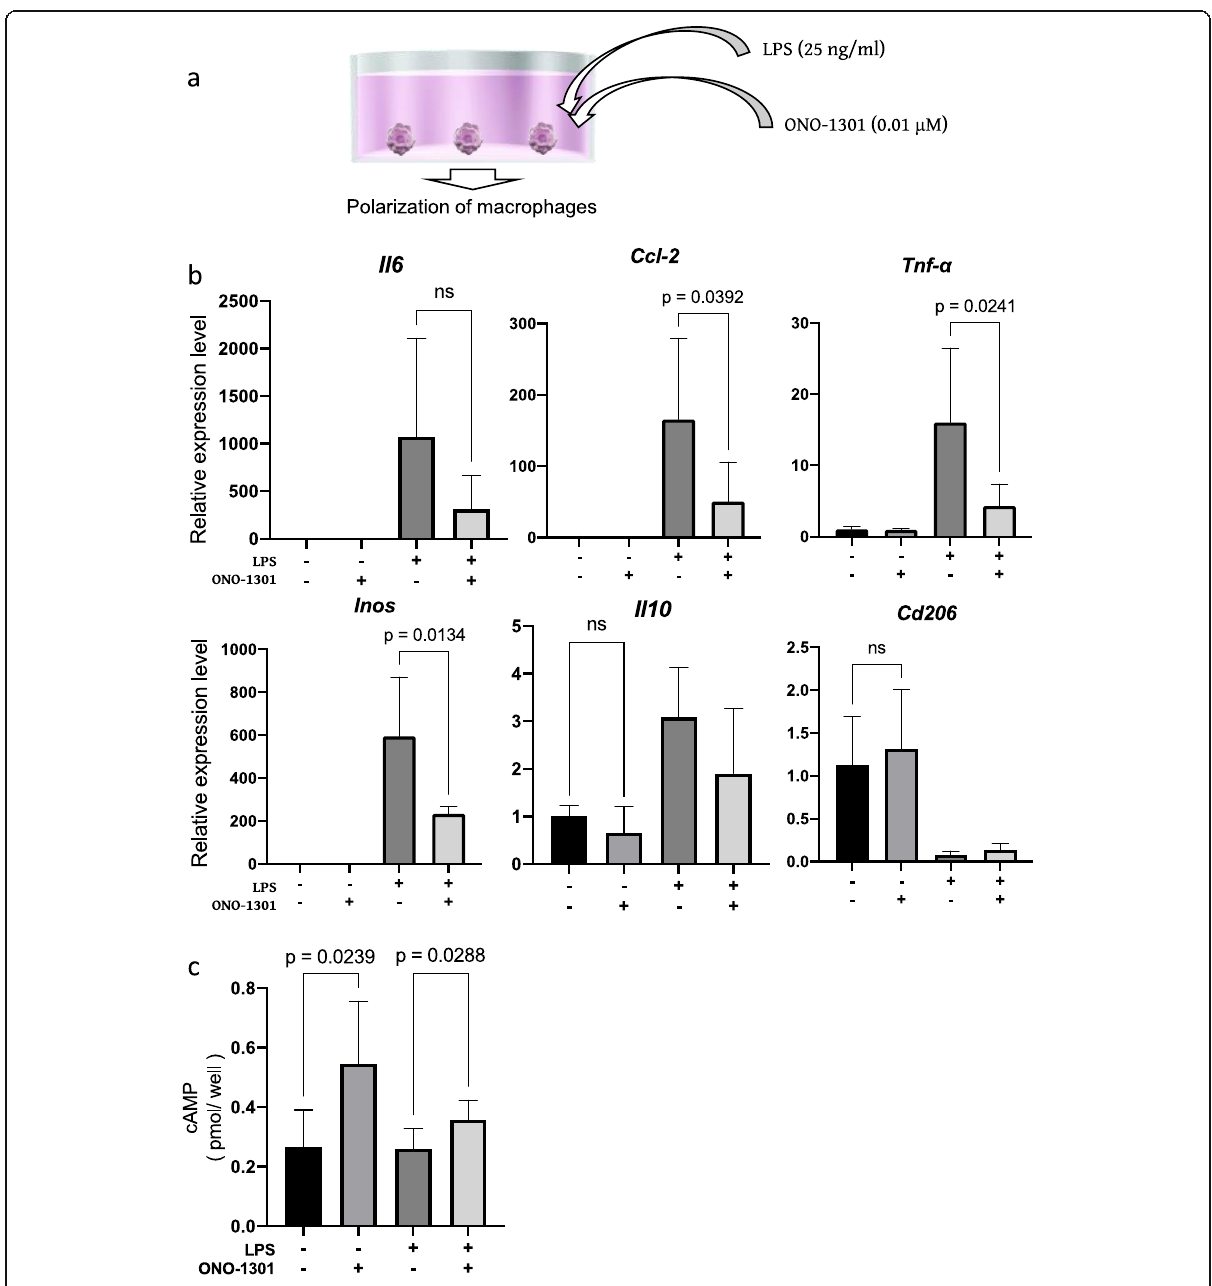
Fig. 4 Effects of ONO-1301 against macrophages in vitro. A Schematic of the experiment. B After addition of lipopolysaccharide (25ng/ml), ONO-1301 (0.01 μ M) to macrophage cultures, mRNA expression levels of Il6 , Ccl2 , Tnfa , Inos , Il10 , and Cd206 were analyzed (each experiment was repeated seven times). C cAMP levels of each condition were analyzed of three independent experiments. Data are presented as mean ± standard deviation. ns: not